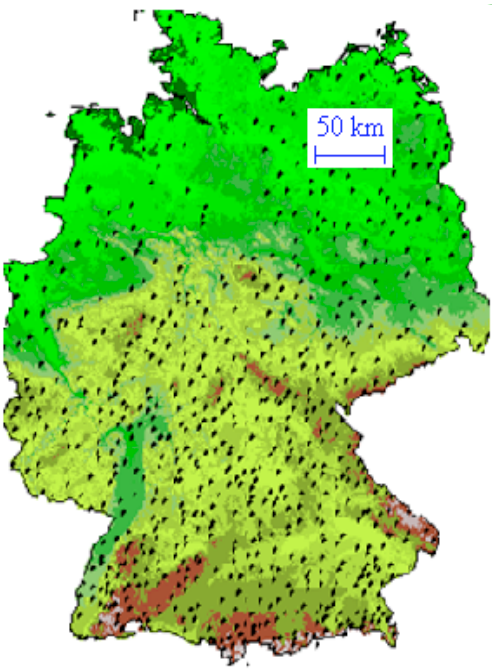
Figure 1. Orographical map of Germany with 759 daily opera- tionally measuring rain-gauges indicated by black dots. Low areas green, and high areas